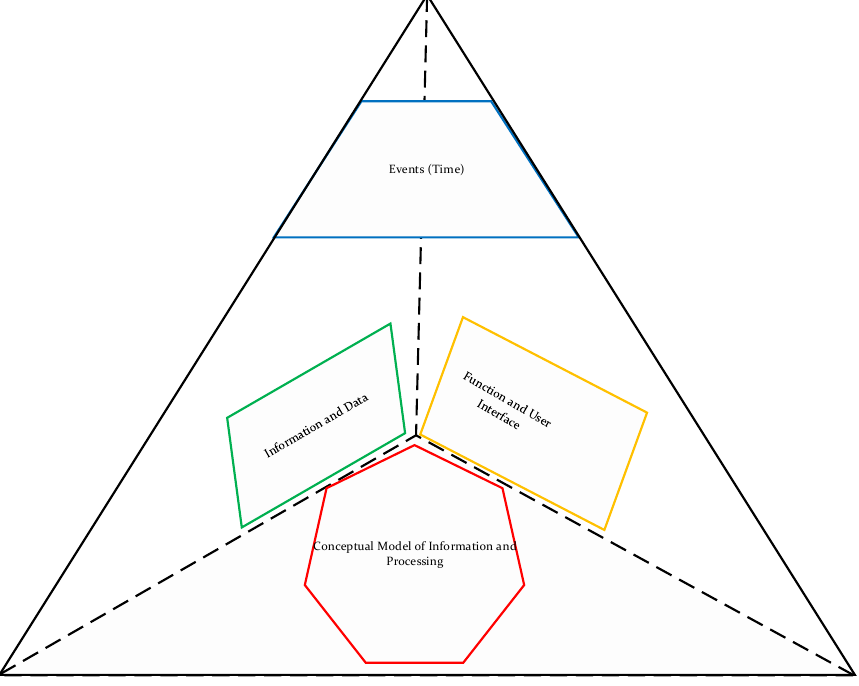
Figure 9. Dichotomy among the Three Facets of Information